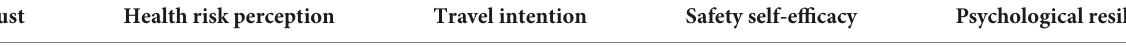
TABLE 4 Predictive correlation of the structural model ( Q 2 ).